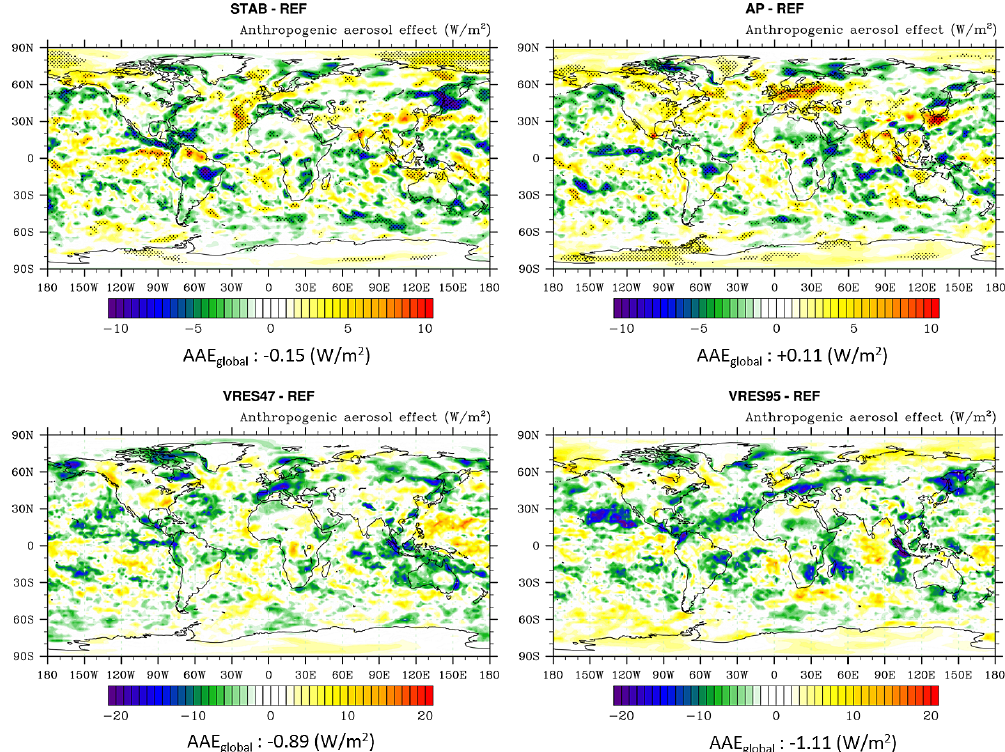
Figure 16. The change in AAE between the STAB, AP, VRES47 and VRES95 simulation and the reference simulation is shown globally. Values below each panel are average values for the areas above. Stippling marks statistically significant differences at the 90% significance